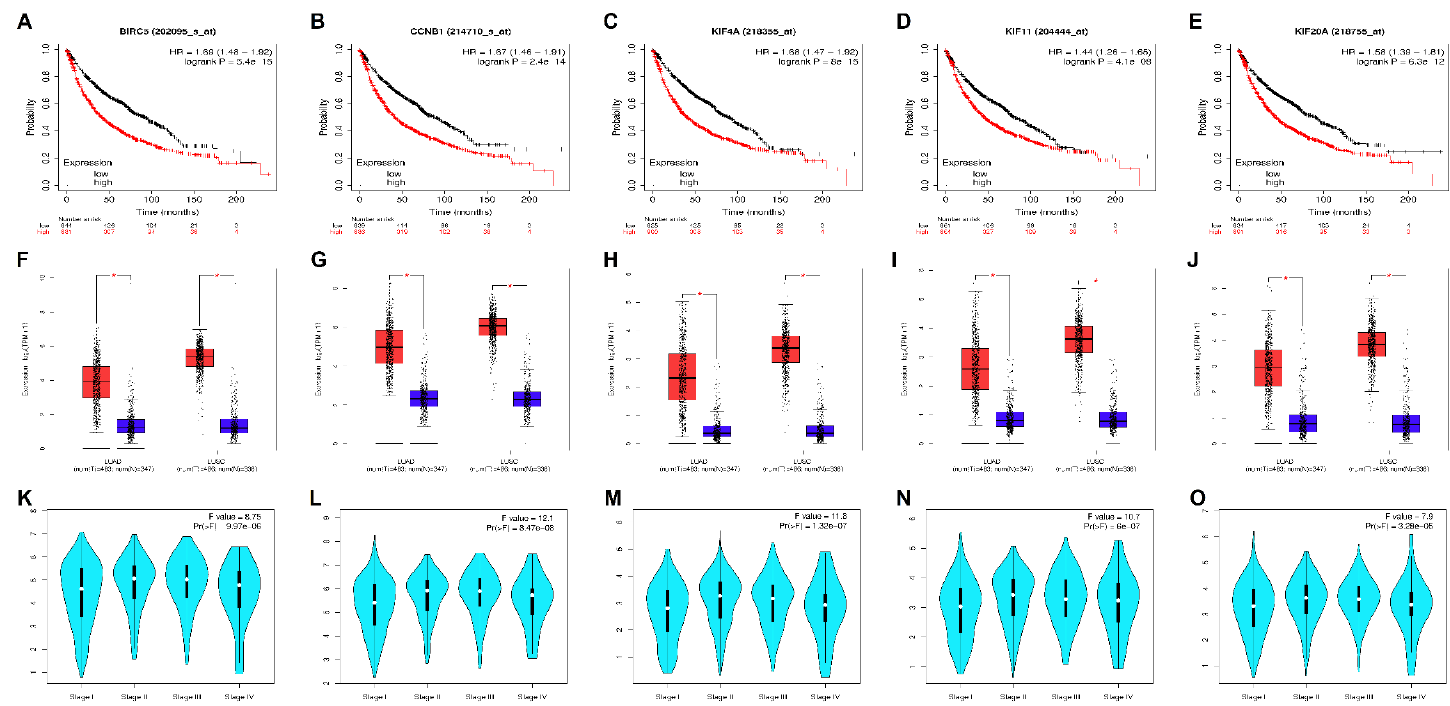
Figure 4. KM survival curves of hub genes [A] BIRC5, [B] CCNB1, [C] KIF4A, [D] KIF11, and [E] KIF20A plotted using KM plotter. The red line denotes patient samples with a higher gene expression level and the black line denotes patient samples with a lower gene expression level. Higher expression levels of these genes tend to worsen the OS in NSCLC patients. All these genes were highly significant (log rank p < 0.05). Boxplots comparing the relative expression levels of hub genes [F] BIRC5, [G] CCNB1, [H] KIF4A, [I] KIF11, and [J] KIF20A in LUAD and LUSC patients with respect to normal samples. The thick horizontal line in the middle depicts the median, and the lower and upper limits of each box depicts first and third quartiles, respectively. The bottom and top of the error bars depict the minimum and maximum values of expression data. The red and blue boxes depict the NSCLC (LUAD / LUSC) and normal tissues. The method for di ff erential analysis was one-way ANOVA, using disease state as a variable for computing di ff erential expression and asterisk signifies statistically significant with each dot indicating a distinct tumor or normal sample. Violin stage plots of hub genes [K] BIRC5, [L] CCNB1, [M] KIF4A, [N] KIF11, and [O] KIF20A showing the association of their mRNA expression levels and various tumor stages in NSCLC patients. The white dots and black bars depict the median and interquartile ranges, respectively. The width of the turquoise colored shapes depicts the distribution density. The stages of lung cancer were represented by abscissa and the expression level of each hub genes are represented by its ordinate. The method for di ff erential analysis is one-way ANOVA, using pathological stage as a variable for computing di ff erential expression. A better study fit corresponds to a larger F -value. All the genes were statistically significant at p -value < 0.05 with CCNB1 having the best study fit (i.e., F -value =